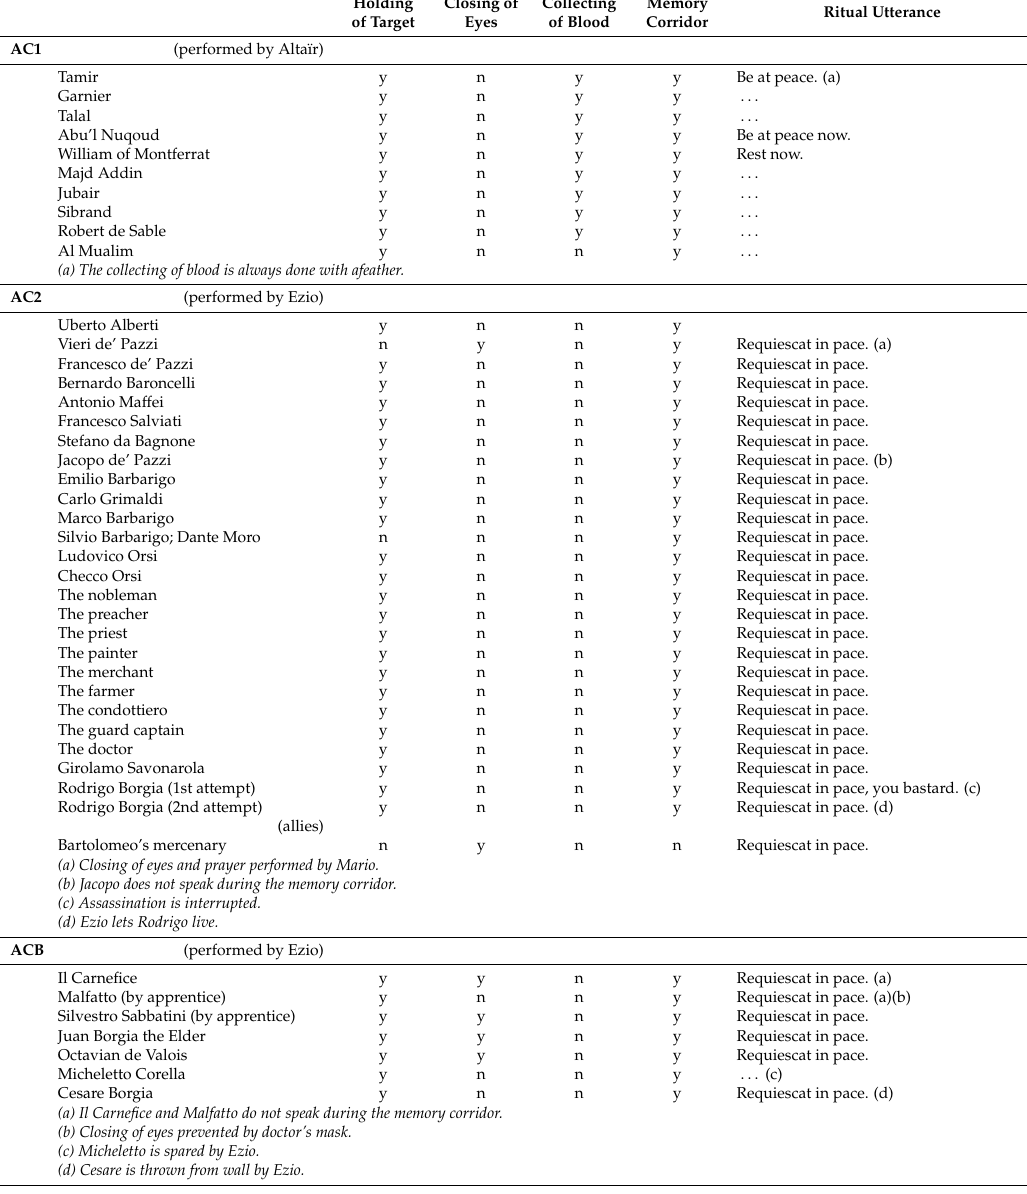
Table A1. Assassinations. Overview of all assassinations performed in the p rimary games of the Assassin’s Creed series. The list includes (1) all assassinations that triggered the Animus’ memory corridor; (2) high profile assassinations that did not trigger the memory corridor; and (3) allies to whom the same rites are applied.